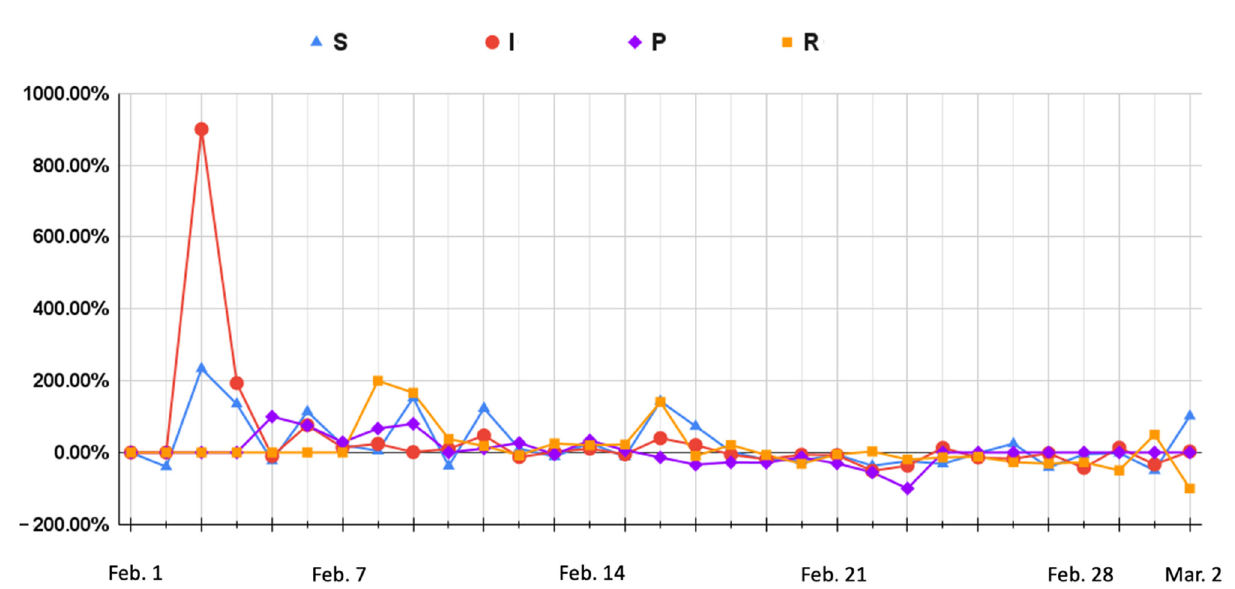
Figure 4. The trends of SIR.